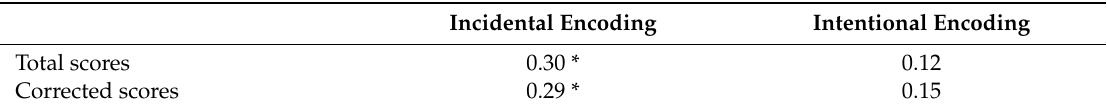
Table 3. Correlations between vigilant attention (aggregate score) and location-exchanged objects during divided attention incidental and intentional encoding conditions.